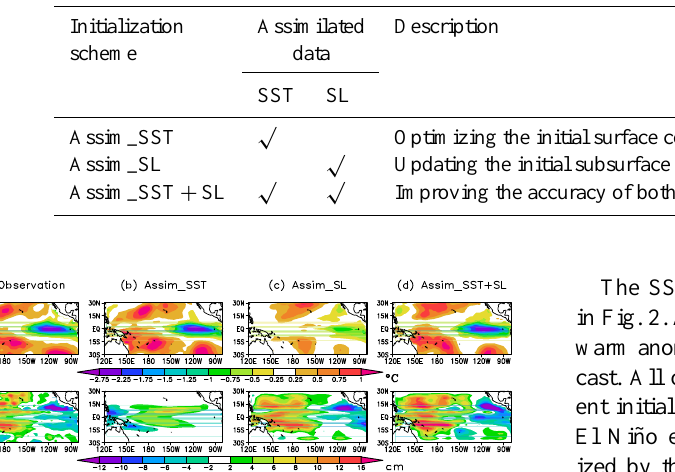
Table 1. Summary of the initialization scheme design.